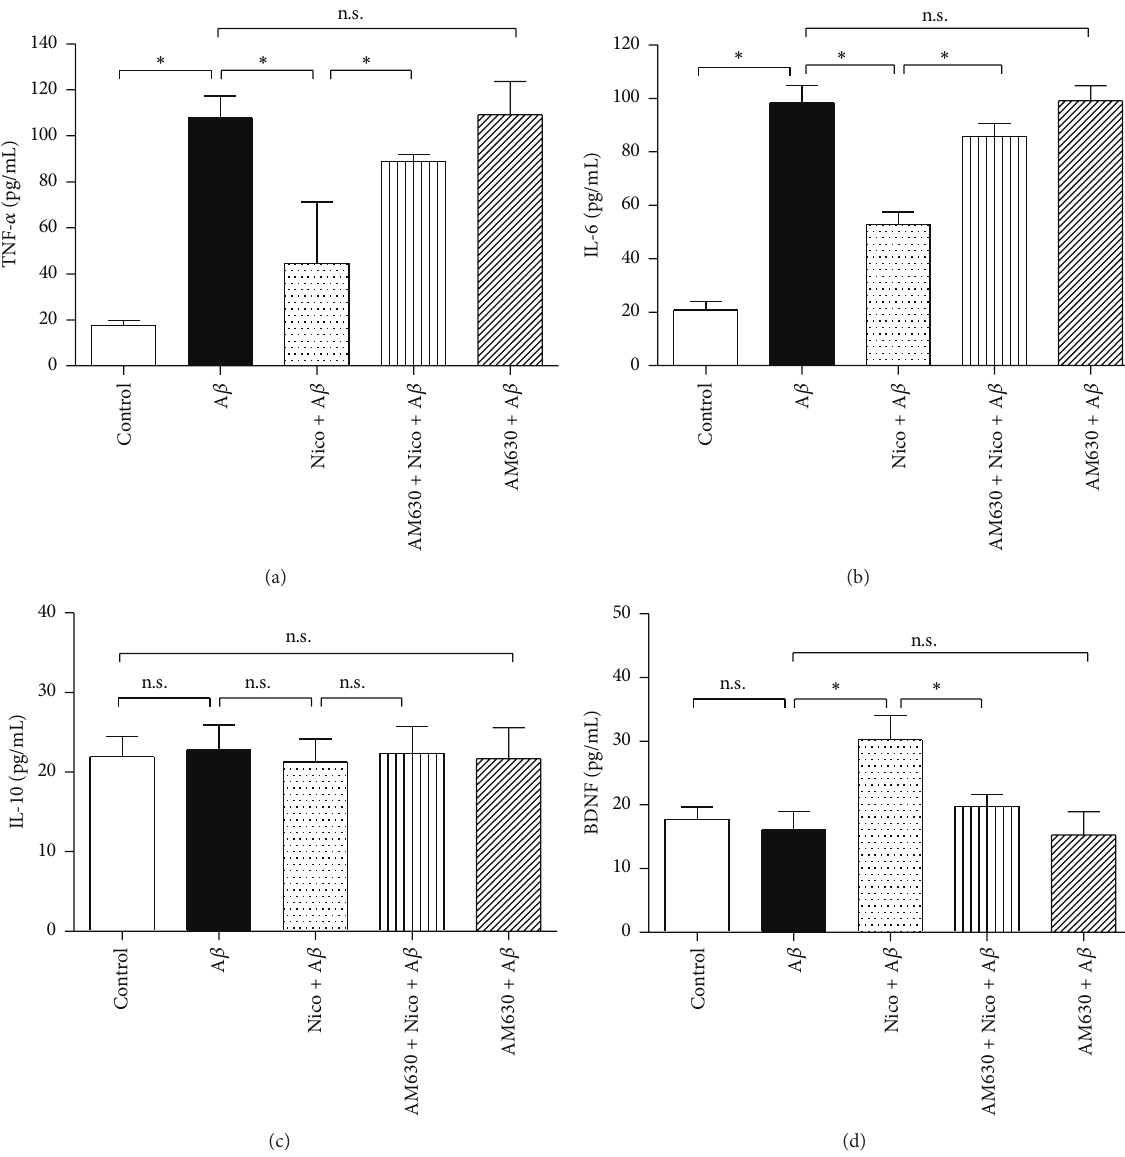
Figure 4: CB2 receptor antagonist partially abolished nicotine-induced effects on TNF- 𝛼 , IL-6, and BDNF releases. The microglial cells were divided into five groups: control: cells cultured in drug-free medium; A 𝛽 : cells cultured in the medium containing 5 𝜇 M A 𝛽 ; nicotine (Nico) + A 𝛽 : cells cultured in the medium containing 10 𝜇 M nicotine and 5 𝜇 M A 𝛽 ; AM630 + Nico + A 𝛽 : cells cultured in the medium containing 10 𝜇 M CB2 antagonist AM630, 10 𝜇 M nicotine, and 5 𝜇 M A 𝛽 ; AM630 + A 𝛽 : cells cultured in the medium containing 10 𝜇 M AM630 and 5 𝜇 M A 𝛽 . After an incubation of 24h, concentrations of TNF- 𝛼 (a), IL-6 (b), IL-10 (c), and BDNF (d) in the supernatants were assessed by using the corresponding reagent kit ( 𝑛 = 6 ). Results are expressed as means ± SD, ∗ 𝑃 < 0.05 ; n.s.: no